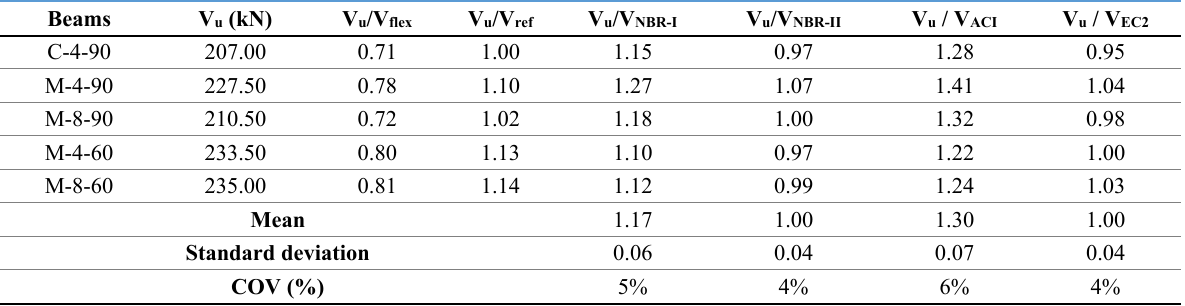
Table 5 - Failure load of the beams and comparison with theoretical estimates.